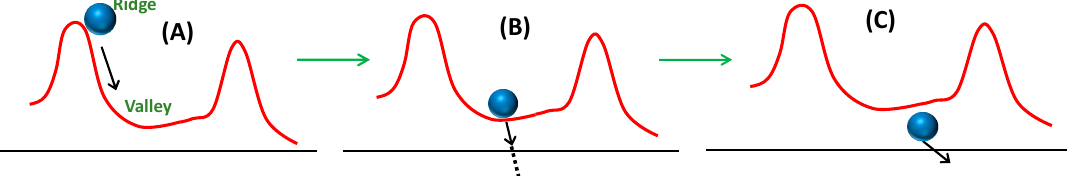
Figure 15. Accelerated water transport on rough membrane comprising of ridge and valley.